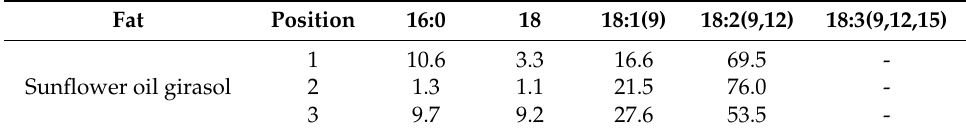
Table 1. Fatty acids that make up sunflower oil and specific stereoanalysis [18]. Results in % moles. Fat Position